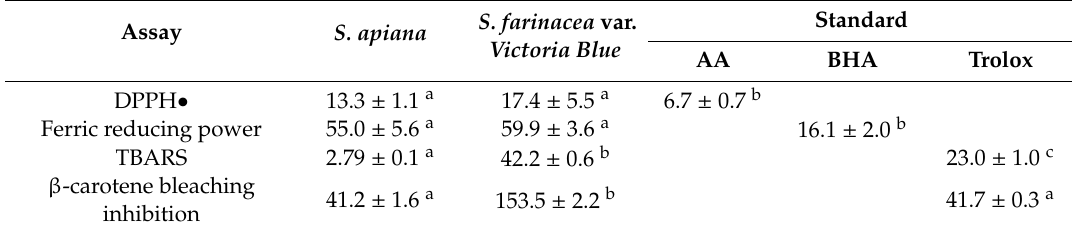
Table 1. Antioxidant activity (EC 50 , µ g / mL) of S. apiana and S. farinacea var. Victoria Blue decoctions. Assay S. apiana